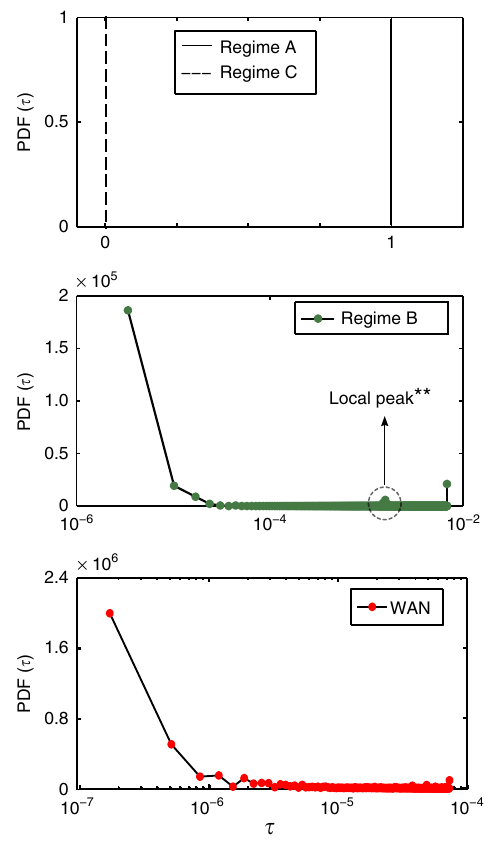
Figure 5 | Probability density functions of coreness of different regimes and the empirical WAN. Regime B, for cost W ¼ 0.92, that maximizes the value of core–periphery measure (independent of system size N ), l ¼ 0.248 (Fig. 4), and the real-world network exhibit a core–periphery structure. The density functions show the probability of having a shell with relative coreness t (relative to a fully connected network). Data are averages over 100